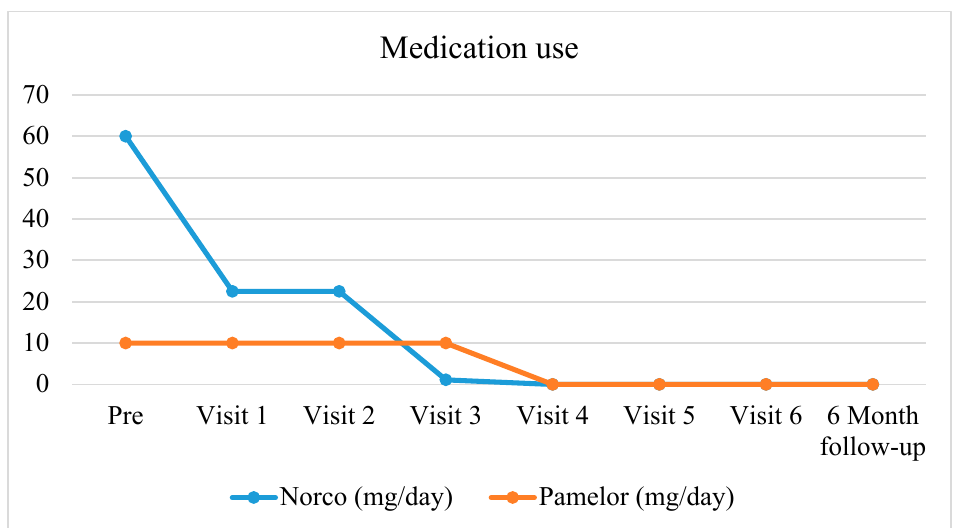
Figure 2. Medication-use for CLBP over the course of the treatment (milligrams/day).